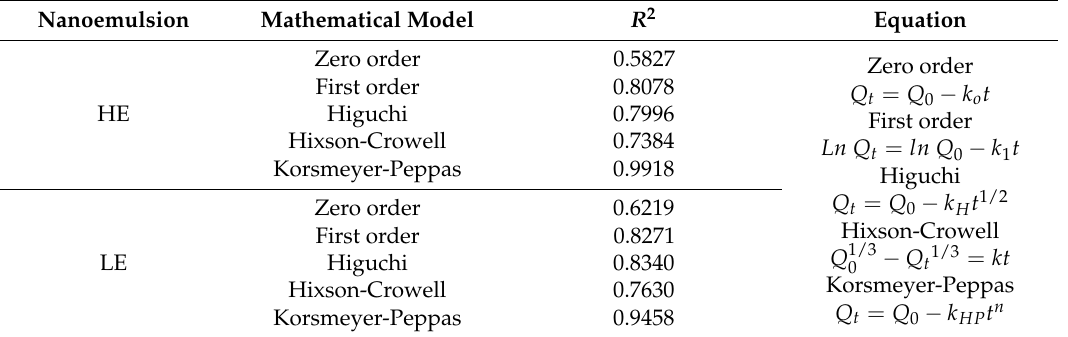
Table 2. Mathematical models used with the release of drug data. Q t : amount of drug released at time t ; Q 0 : amount of drug at time t = 0.